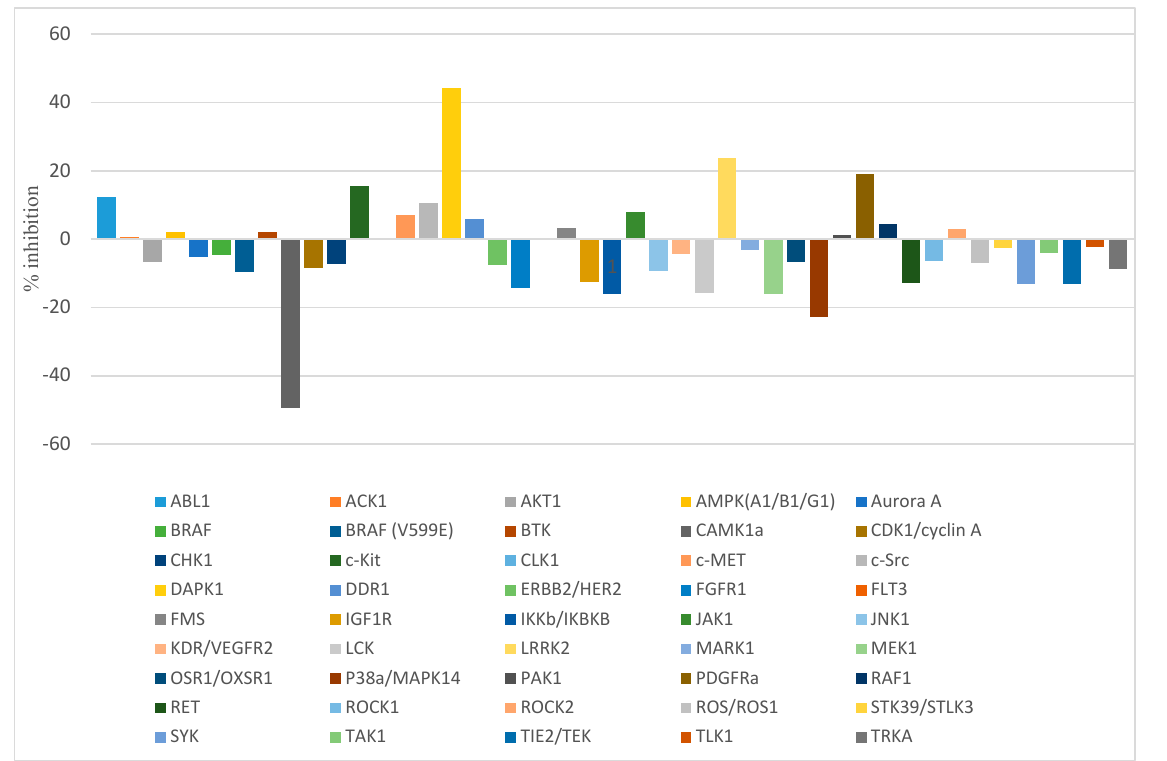
Figure 3. A schematic chart illustrating the enzyme inhibitory activity of compound 4a (10 µM) against a panel of 45 oncogenic kinases. Table 3. DAPK1 kinase % inhibition activity for the final target compounds 4a – r at 10 µ